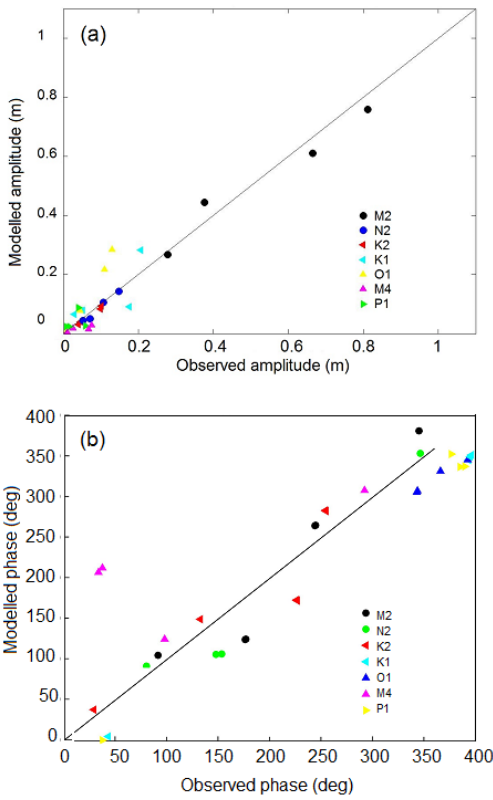
Figure 5. Comparison of modelled and observed (a) tidal ampli- tude and (b) tidal phase at four tide gauge stations close to Singa- pore (Keling, Tanah Merah, Raffles lighthouse and Kukup) station locations are marked in Fig.